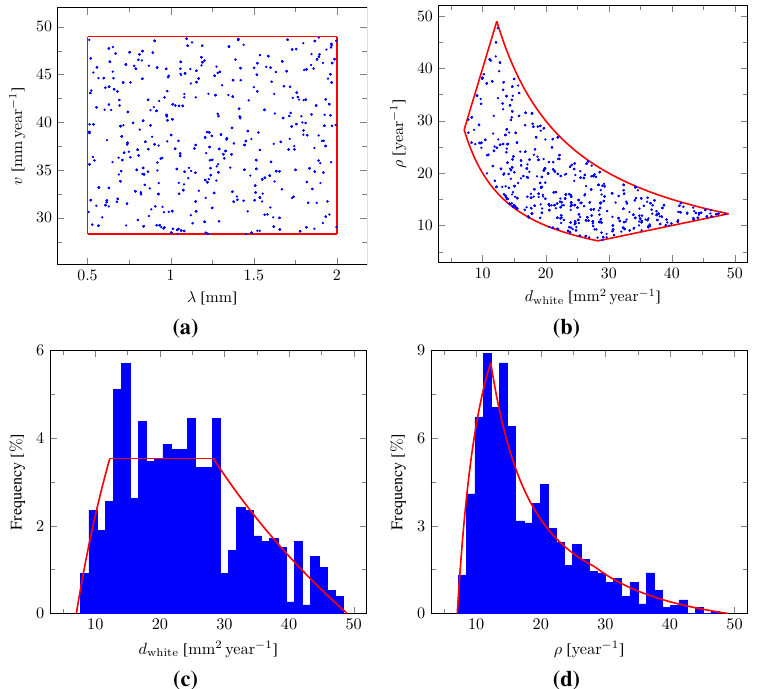
Figure 3. Sampling of the model parameters. ( a ) Empirical joint distribution of the ( λ , v ) values sampled from uniform distributions (blue marks) with superimposed sampling domain bound- ary (red segments). ( b ) Corresponding joint distribution of the derived ( d white , ρ ) values using Equations (12) and (13) (blue marks) with superimposed sampling domain boundary (red curves). ( c ) Empirical marginal distribution of the derived d white values (blue bars) with superimposed theo- retical distribution (red curves). ( d ) Empirical marginal distribution of the derived ρ values (blue bars) with superimposed theoretical distribution (red curves).